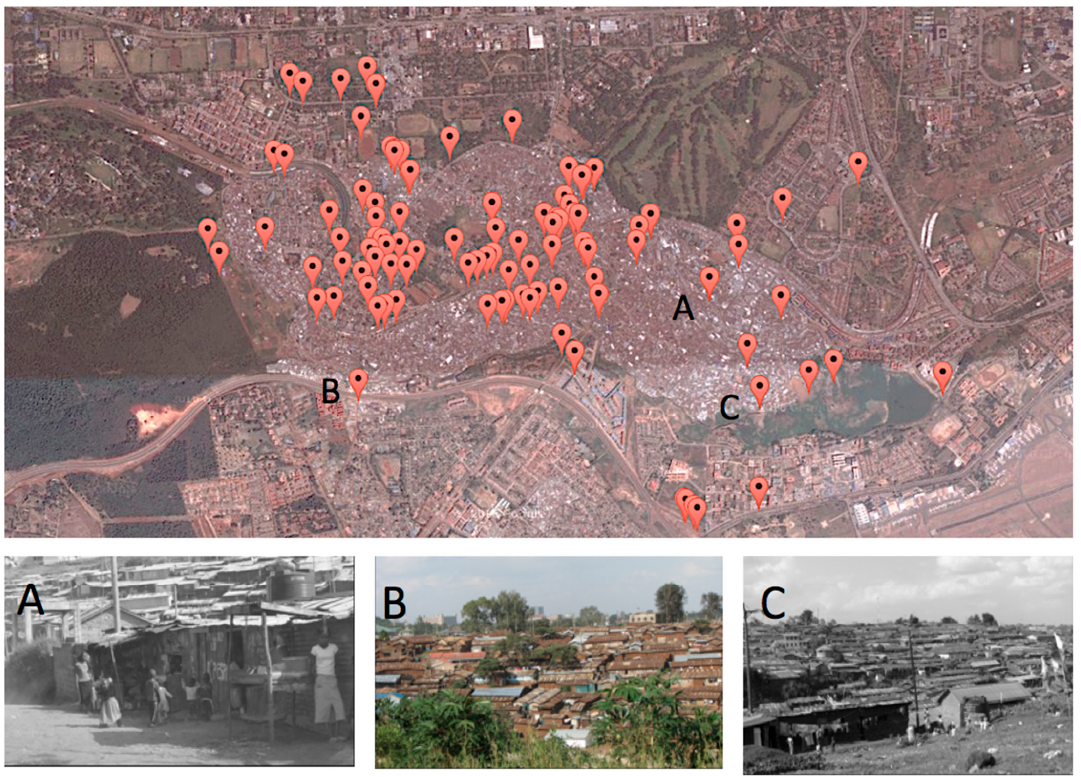
Figure 8. Geotagged Flickr images with word “slum” in their description (background imagery source: ESRI [189]). Images A, B and C represent different views of Kibera embedded within the Flickr data.